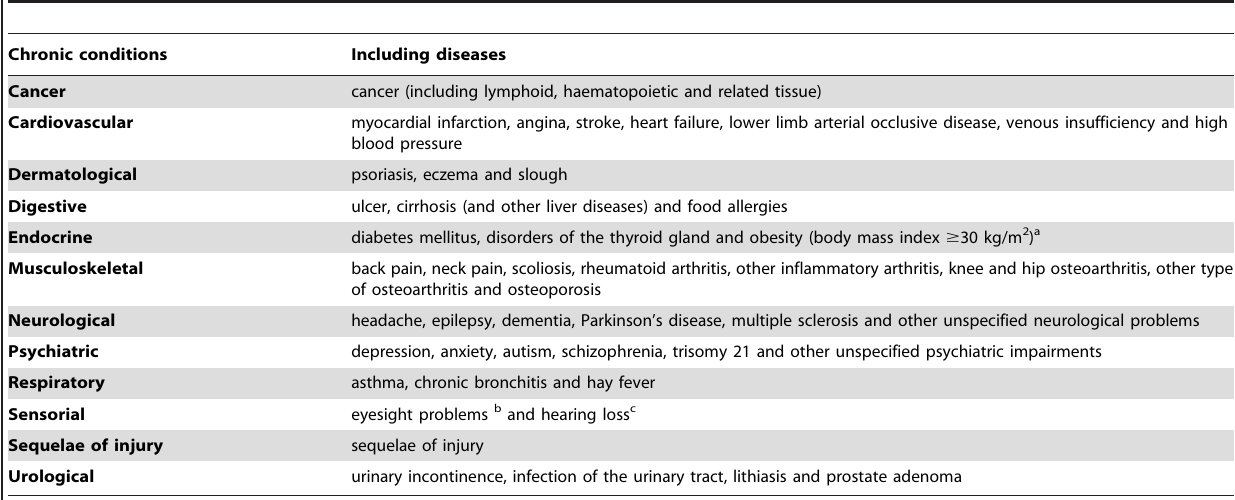
Table 1. Chronic conditions and the included diseases evaluated in estimating the contribution of diseases to disability in the population in